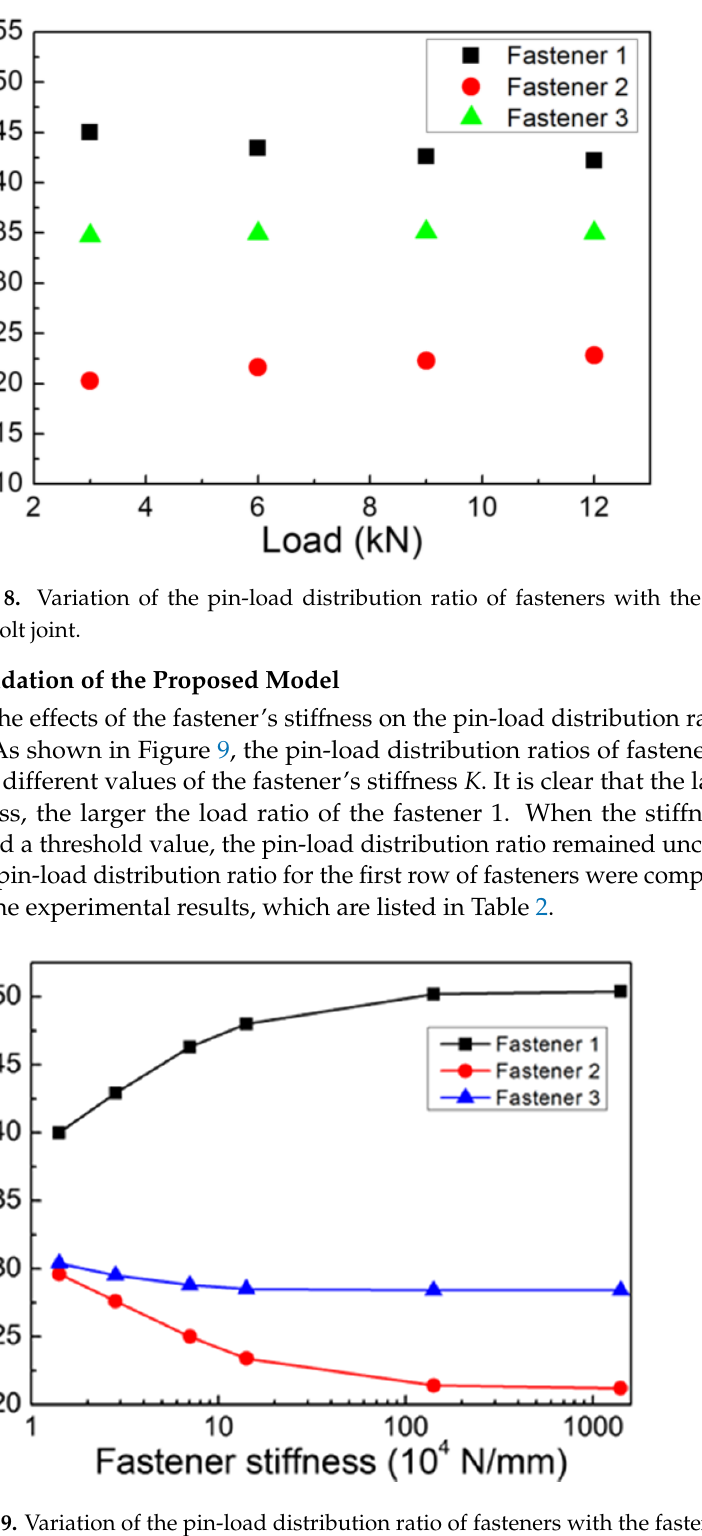
Figure 9. Variation of the pin-load distribution ratio of fasteners with the fastener’s stiffness. Table 2. The pin-load distribution ratio for different values of the fastener stiffness.